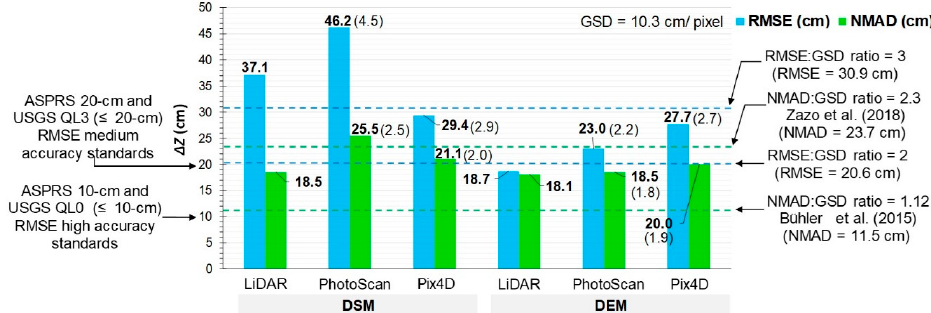
Figure 7. Accuracy (absolute and relative) of UAV-derived models, and comparison with LiDAR (no. of checkpoints = 104). Relative accuracy ratios are shown in brackets. USGS/ASPRS accuracy standards ( left ), as well as expected accuracy ( right ) are shown as horizontal dashed lines.